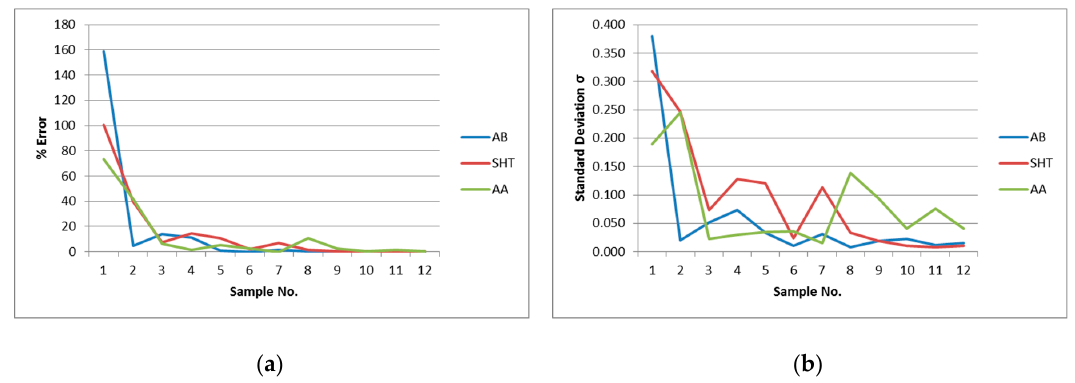
Figure 11. ( a ) Distortion % Error and ( b ) Distortion Standard Deviation Comparison under AB, SHT, and AA conditions.